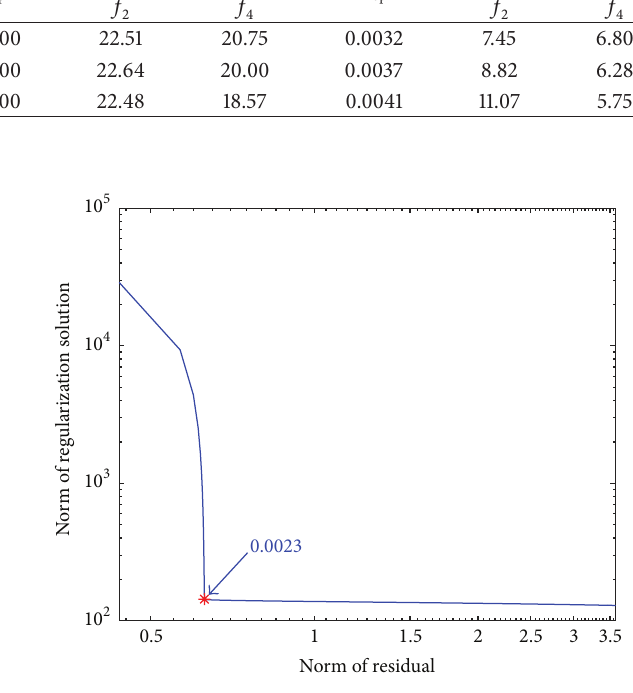
Figure 6: QF for impact load identification of SISO system.